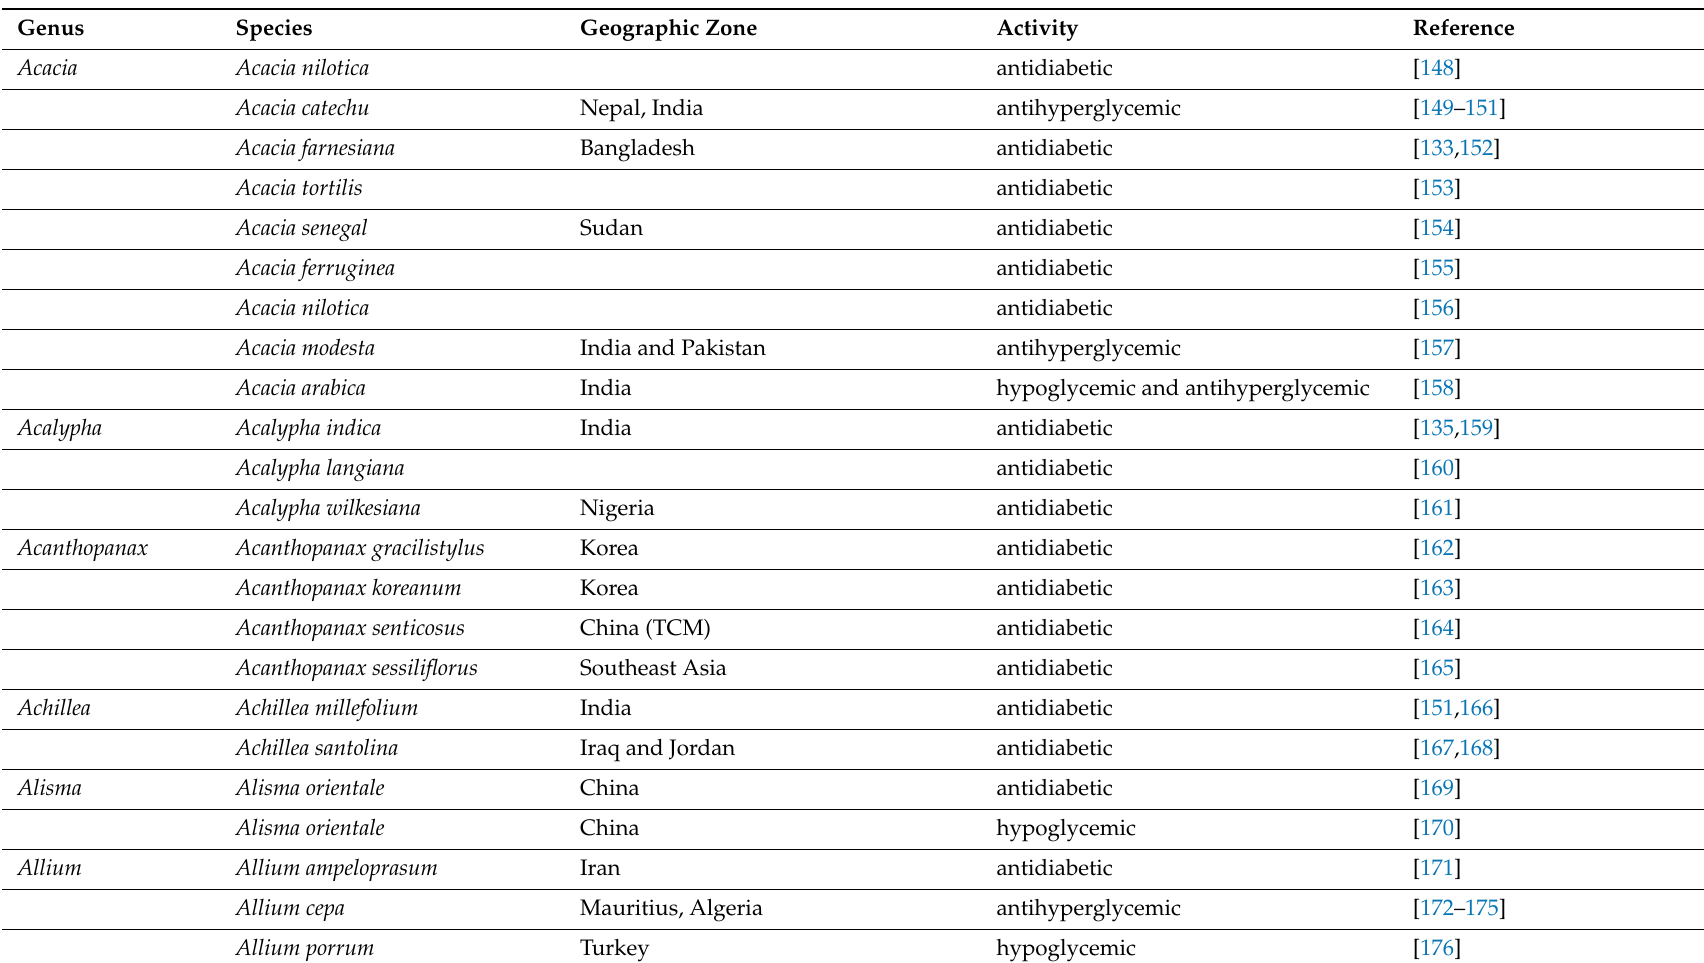
Table 1. Antidiabetic